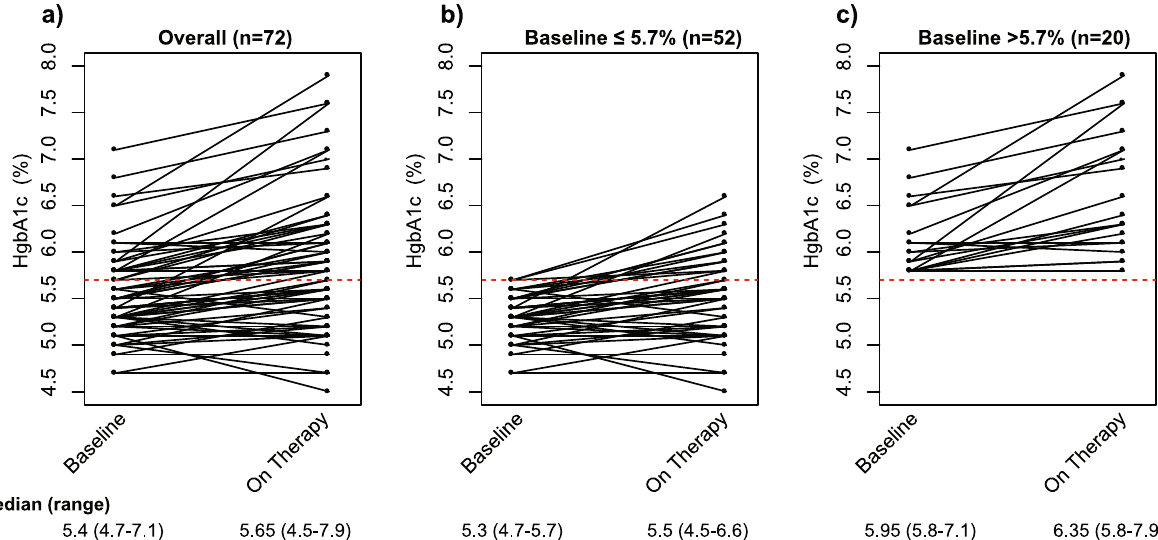
Fig. 2 Changes in HbA1c at baseline and subsequent levels measured while on PGM therapy for patients with more than one measurement. ( a ) all patients ( n = 72); ( b ) those with normal baseline HbA1c ( n = 52); ( c ) elevated baseline HbA1c ( n = 20).